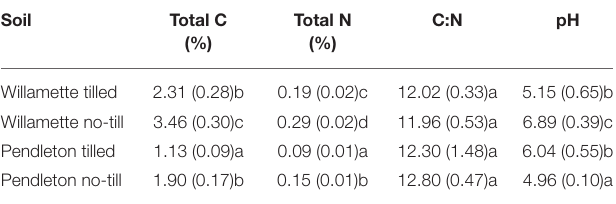
TABLE 1 | Selected properties of the soils utilized in this